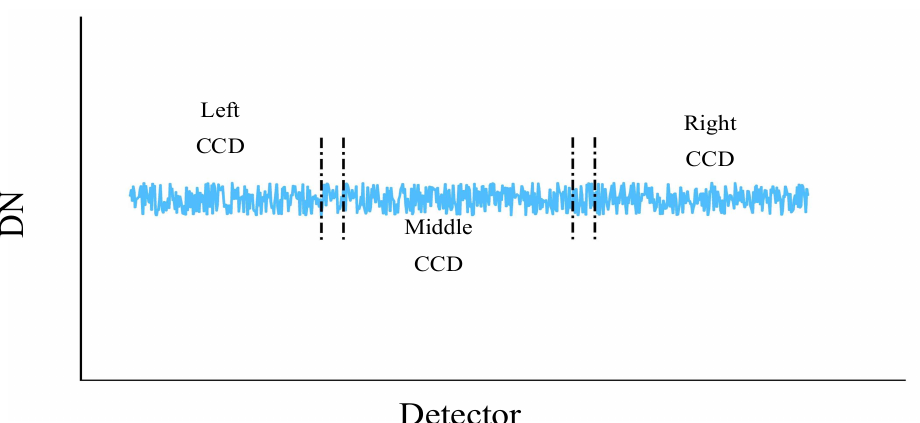
Figure 3. The three CCD arrays of the GF-7 satellite multispectral sensor. A relative radiometric accuracy evaluation of the GF-7 satellite multispectral im- agery, using uniform scenes (such as desert and ocean), was performed in this study. Sev- eral large uniform scenes, including the Libya and Algeria pseudo-invariant calibration sites (PICs), have been used for evaluating the relative radiometric uniformity. The nonu- niform variations in the GF-7 imagery could be detected using these large uniform scenes. Table 3 shows the worldwide uniform sites chosen for the relative radiometric accuracy assessment in this study.